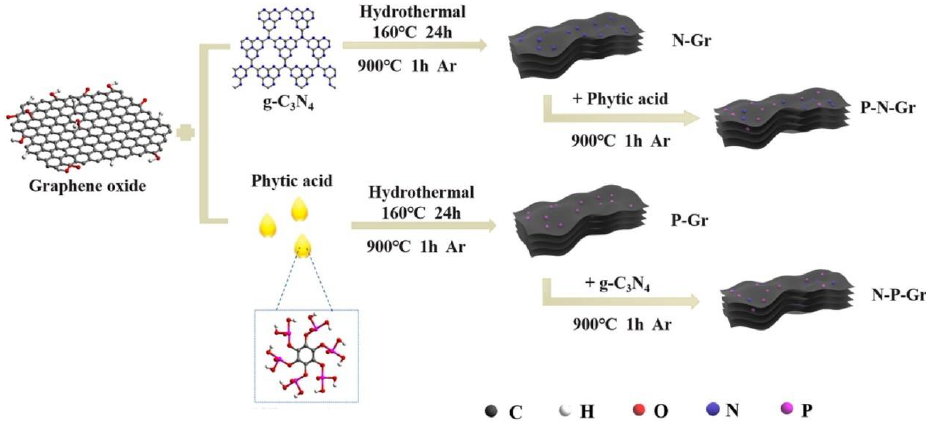
Figure 3. Schematic illustration of different synthesis strategies for N- and P-doped graphene